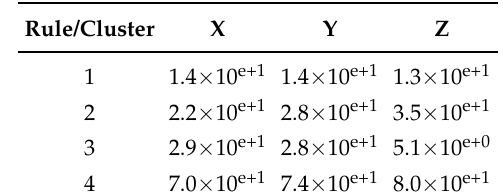
Table 1. Cluster centers for CIEXYZ values.